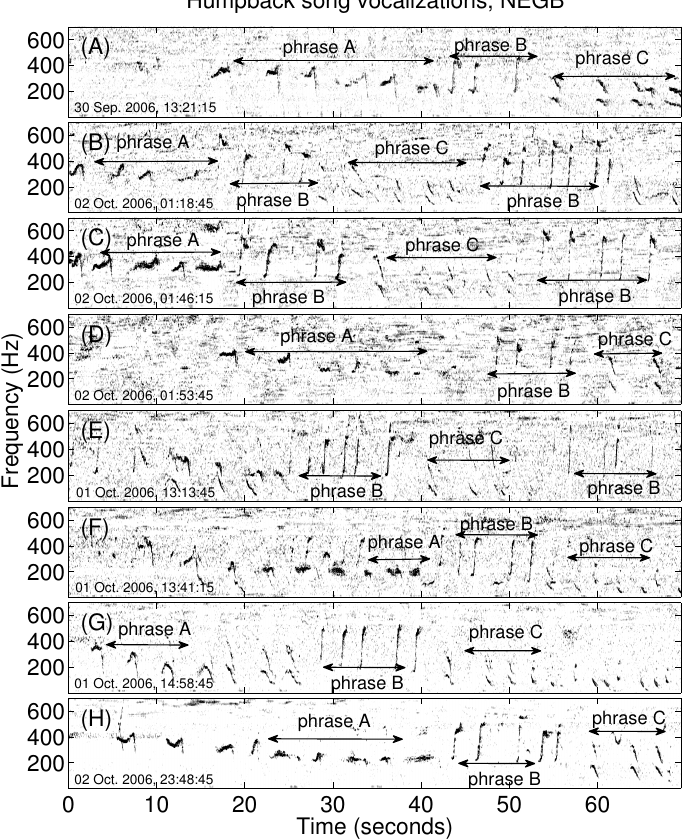
Figure 2. Examples of beamformed spectrograms containing humpback song vocalizations originating from the NEGB direction drawn from both day and nighttime recordings in the 27 September to 3 October 2006 observation period in the Gulf of Maine, starting at ( A ) 13:21:15 EDT on 30 September 2006; ( B ) 01:18:45 EDT on 2 October 2006; ( C ) 01:46:15 EDT on 2 October 2006; ( D ) 01:53:45 EDT on 2 October 2006; ( E ) 13:13:45 EDT on 1 October 2006; ( F ) 13:41:15 EDT on 1 October 2006; ( G ) 14:58:45 EDT on 1 October 2006 and ( H ) 23:48:45 EDT on 2 October 2006 and each lasting roughly 70 s. The humpback song vocalizations are composed of repetitive phrases A, B and C. The spectrograms in Figures 2–4 are created from short time Fourier transforms of the audio data (sampling frequency = 8000 Hz, frame = 1024 samples, overlap = 15/16, Hann window). The times indicated are Eastern Daylight Time